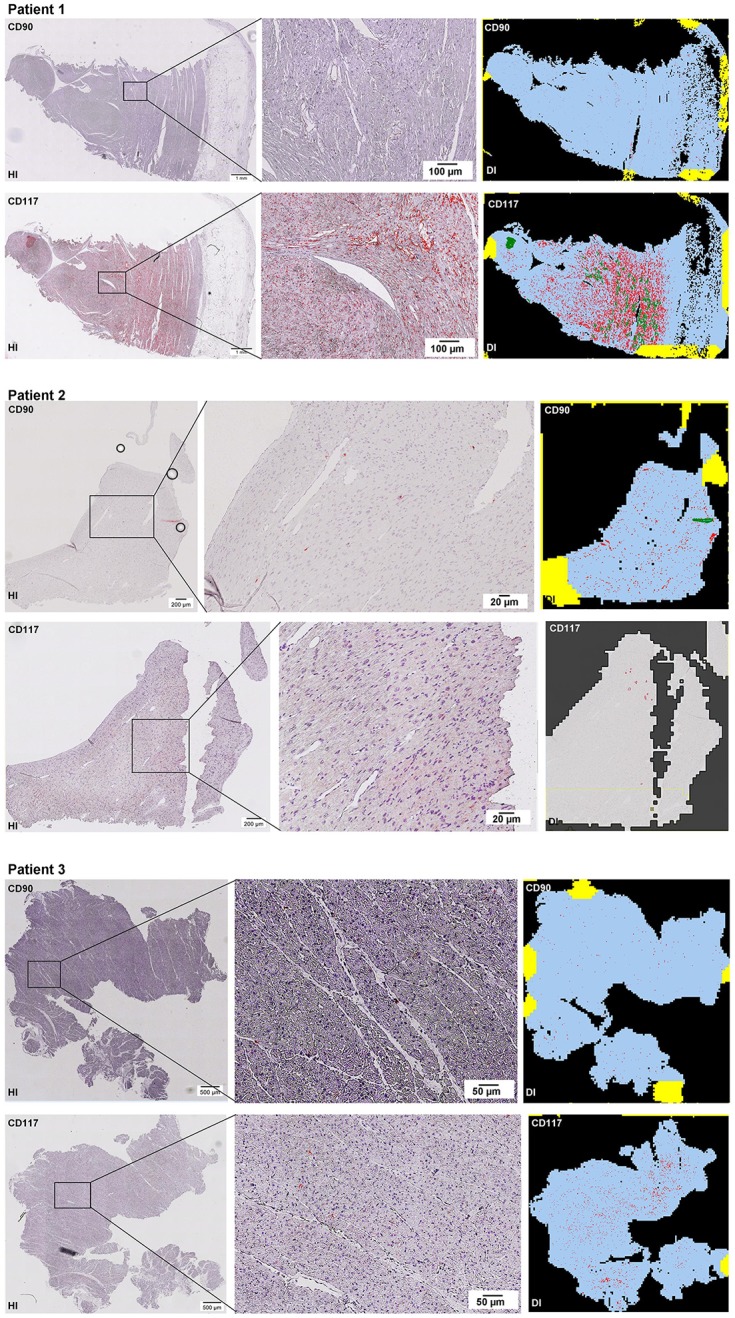
Histological and digital images of all tissue sections (n = 92). (HI) Histological whole slide images scanned with virtual slide microscope VS120 and (DI) reprocessed images, resulting from digital image analysis using the Definiens Tissue Phenomics® Technology. (2) Healthy cardiac patients, (3) patients with Myocarditis, (4-7) patients with ICM, (8-10) patients with DCM. Full-size images are available for download (https://figshare.com/s/13e838d63dfeac772894).